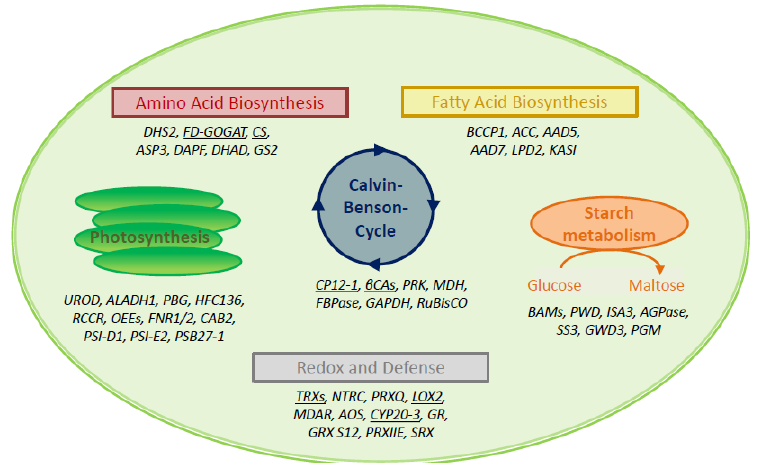
Figure 2. Simplified assignment of 49 identified polypeptides to six main chloroplast processes. Seven proteins each were assigned to the Calvin–Benson cycle (CBC) and associated processes, to starch metabolism and amino acid biosynthesis. Six polypeptides belonged to fatty acid synthesis. Eleven proteins each function in light reactions of photosynthesis and the combined group of redox regulation and stress